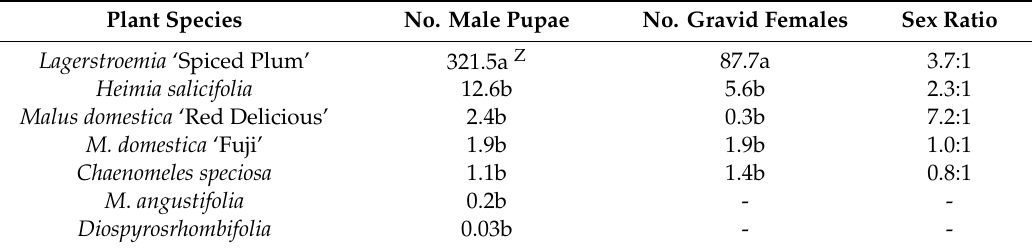
Table 4. The number of male pupae and gravid females, and sex ratio (male to female ratio) on seven plant species and cultivars infested with Acanthococcus lagerstromiae from June to December